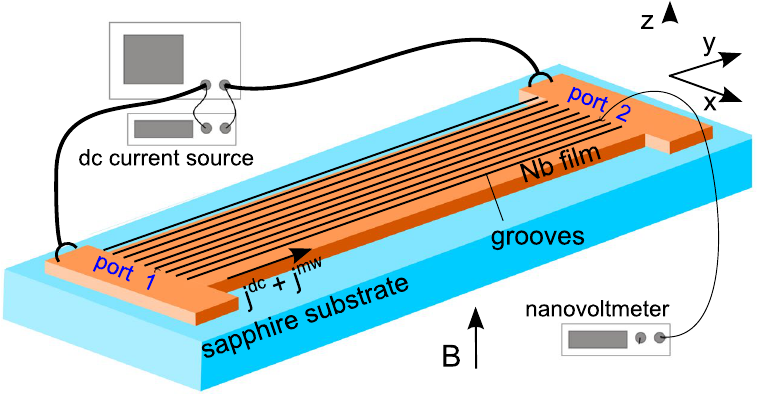
Figure 1. Sketch of the experimental setup: A combination of dc and mw current densities j + j mw is applied to a superconducting Nb microstrip. The microstrip contains an array of 500 nm-spaced nanogrooves milled by focused ion beam. The Lorentz force causes the vortices to move parallel to the x -axis. The measurable quantities are the dc voltage and the absolute value of the forward transmission coefficient S 21 of the mw power at port 2 with respect to that at port